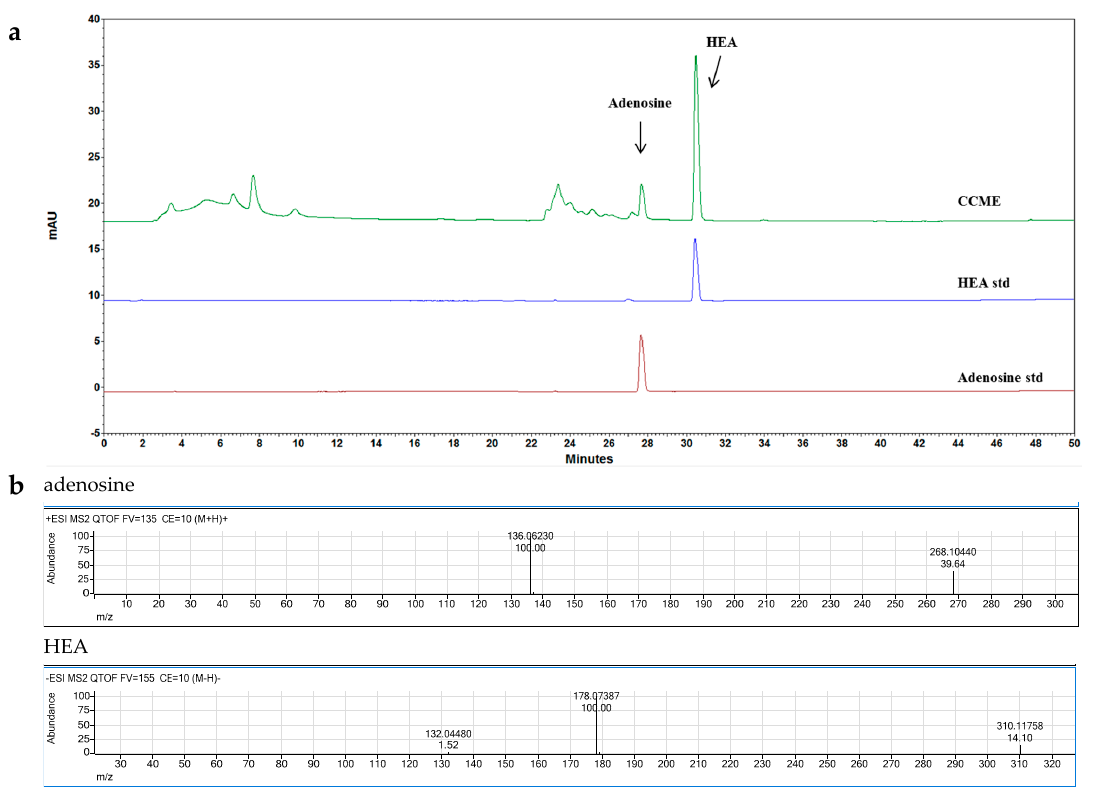
Figure 6. ( a ) HPLC of adenosine and HEA extracted from C. cicadae with retention times labeled at 27.7 min for adenosine and 30.8 min for HEA. Twenty microliters of adenosine or HEA; ( b ) LC- QTOF/MS spectra of adenosine with parental ion detected at m / z 268.10440; HEA with parental ion detected at m / z 310.11758.